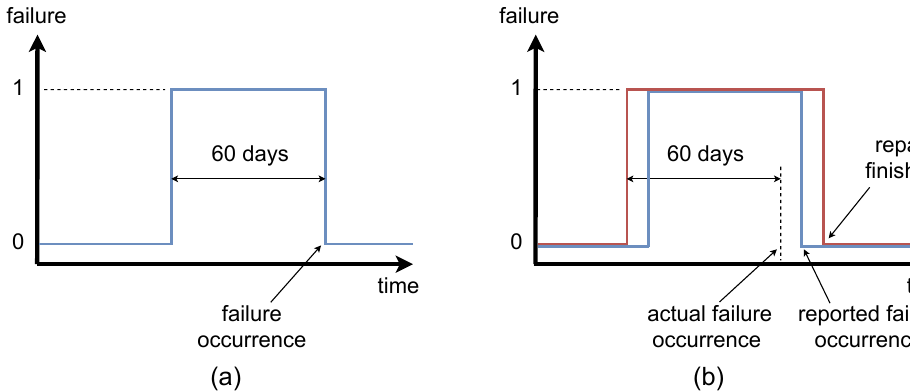
Figure 7. Binary target variables, ( a ) Initial target variable, ( b ) Improved target variable.